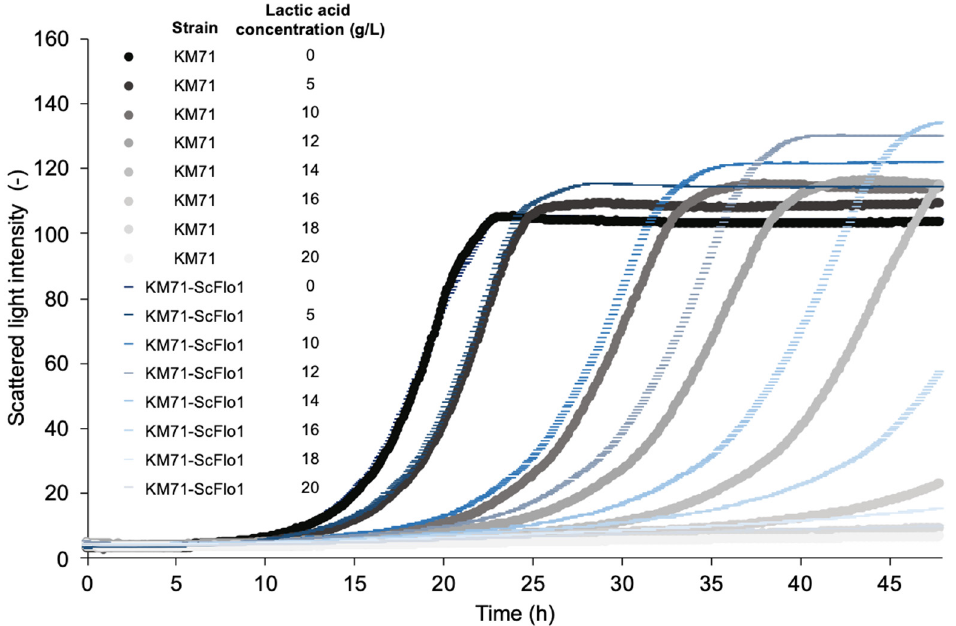
Figure 2. E ff ects of various lactic acid concentrations in YPD medium (liquid culture) on the growth of P. pastoris with or without ScFlo1 overexpression. P. pastoris KM71 and KM71-ScFlo1 were cultivated in YPD medium with di ff erent concentrations (0, 5, 10, 12, 14, 16, 18, and 20 g/L) of lactic acid in a micro fl ower plate. The cells were grown in the BioLector microfermenter (m2p labs) at 30 °C at 1100 rpm with 70% humidity for 48 h. Plates were sealed with porous fi lm to minimize evaporation. The experiments were performed in biological triplicate.